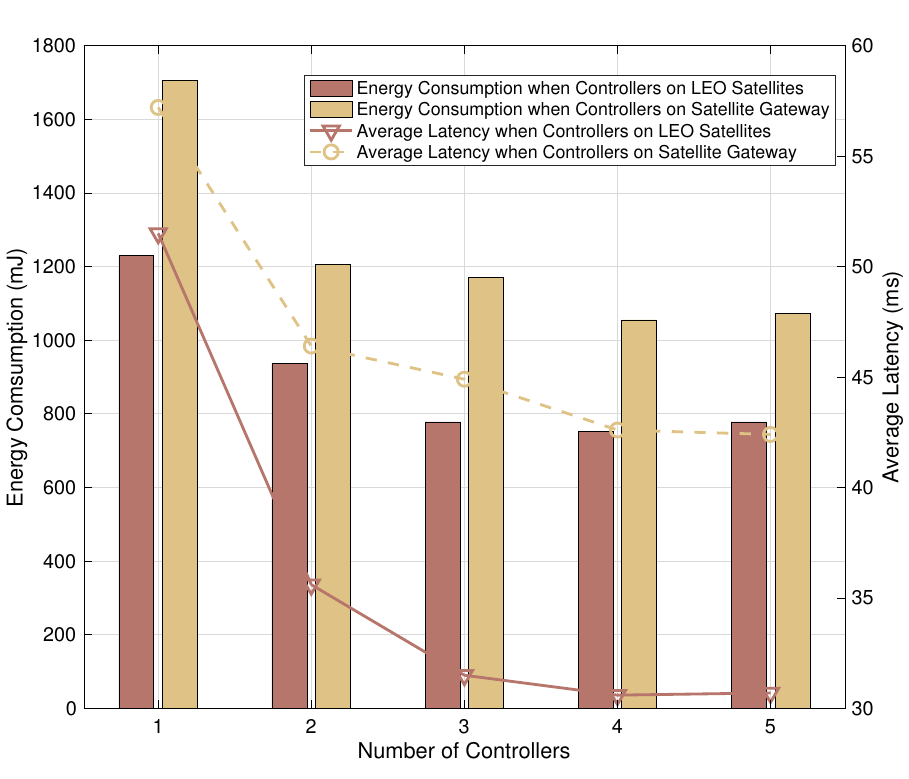
Figure 5. Energy consumption and average latency when controllers on different